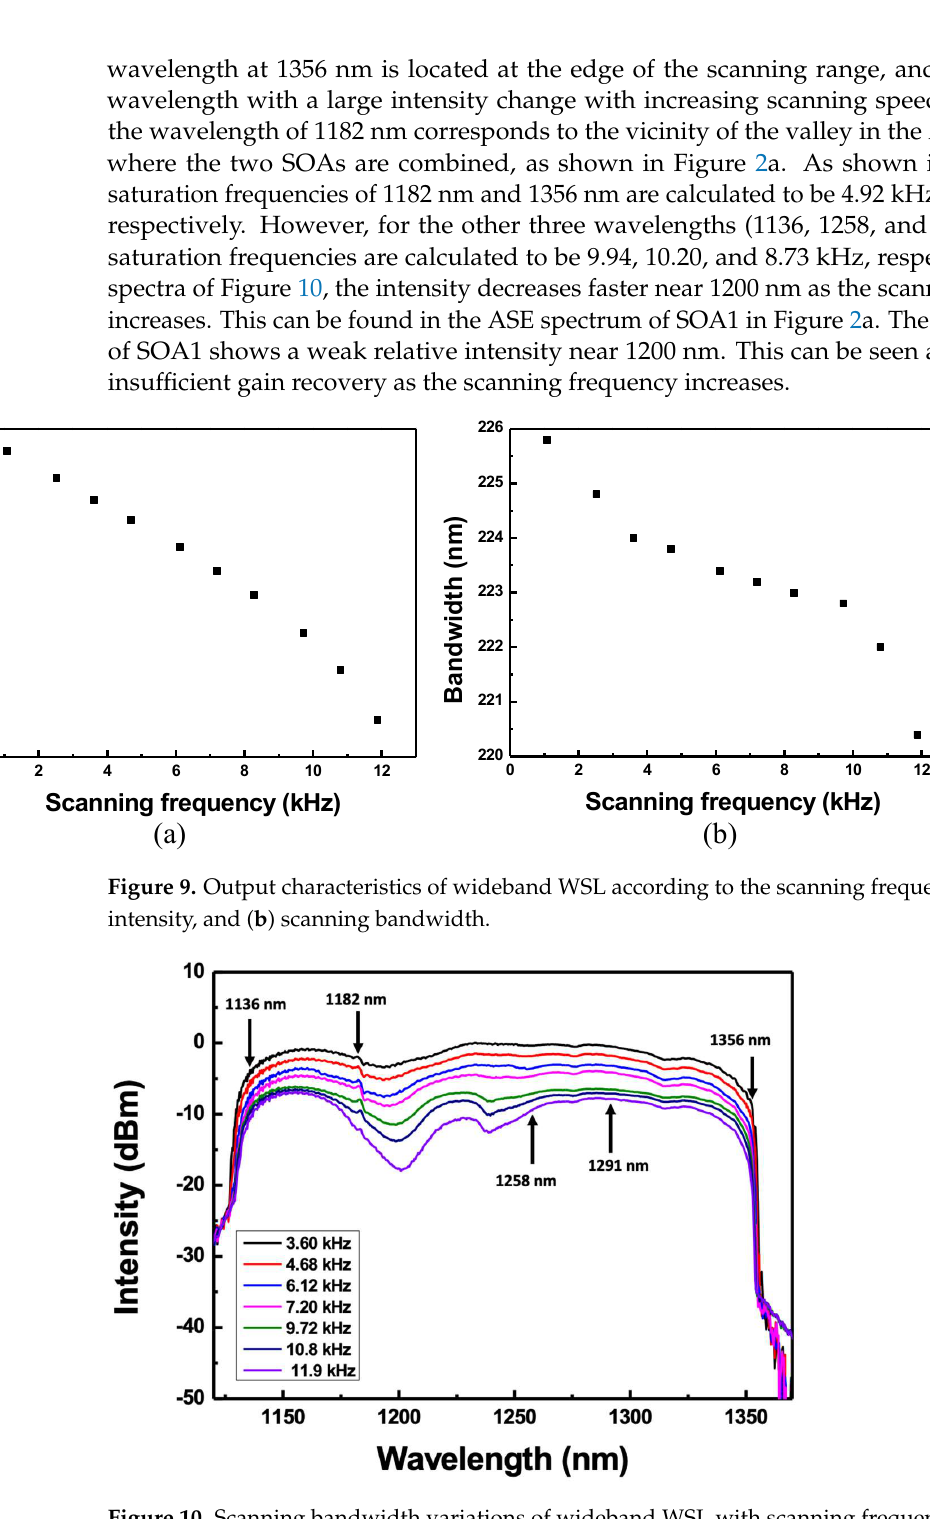
Table 1. Small signal gain and loss per cycle and calculated frequencies of saturation limit at each wavelength from the broadband.